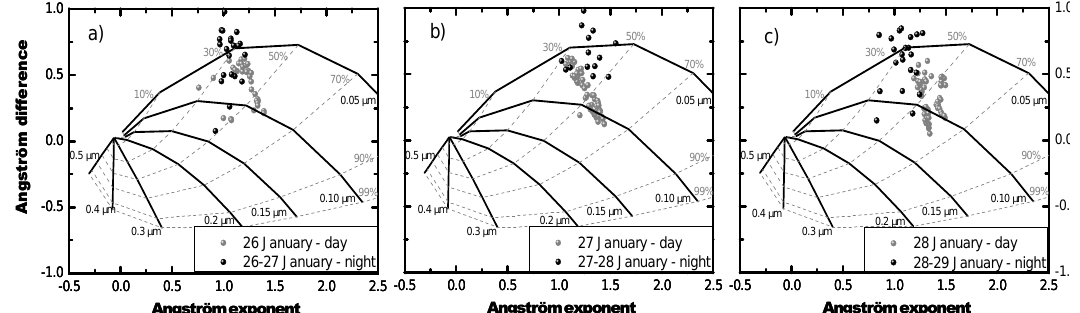
Fig. 12. Angstr¨om exponent difference δα = α (440–670nm) − α (670–870nm) as function of α (440–870nm) at daytime and δα = α (436– 670nm) − α (670–880nm) as function of α (436–880nm) at nighttime, for a winter case study. The data corresponds to the period from 26 to 29 January Figure 12: Angström exponent difference δα = α (440-670 nm) - α (670-870 nm) as function of 1409 α (440-870 nm) at daytime and δα = α (436-670 nm) - α (670-880 nm) as function of α (436-880 1410 nm) at nighttime, for winter case study. The data corresponds to the period from 26 to 29 1411